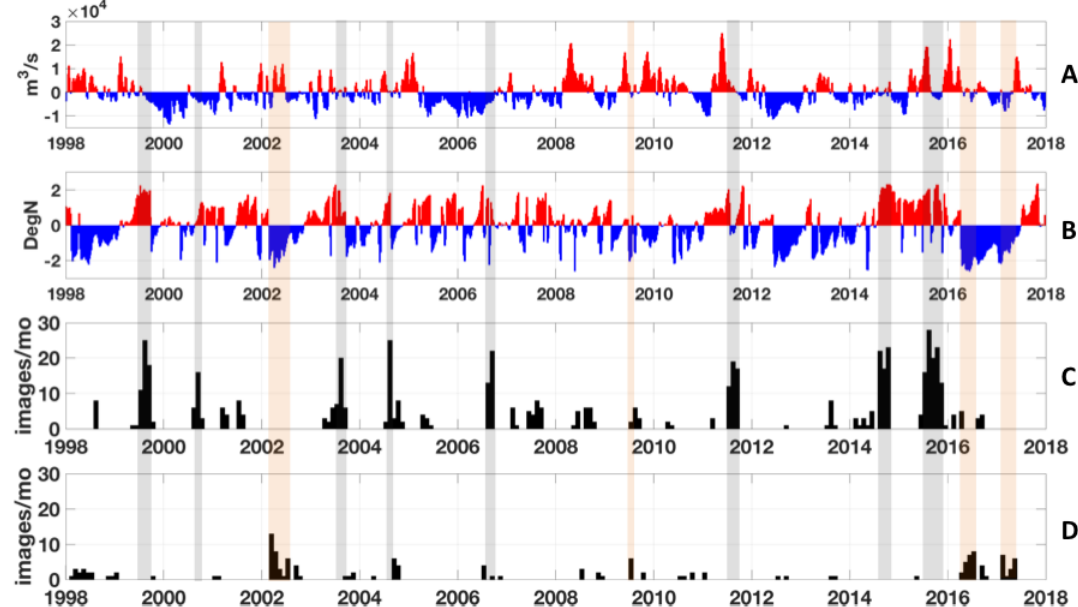
Figure 6. ( A ) Time series of anomalies of Mississippi River discharge. ( B ) Time series of anomalies of the northern extent of the Loop Current. ( C ) Time series of images per month showing evidence of the transport of water from the Mississippi Delta to the Florida Straits. ( D ) Time series of images per month showing evidence of transport from the Campeche Bank to the Florida Straits. In panels a–b, positive anomalies where time series values exceed climatological values are shown in red while negative anomalies are shown in blue. Gray shading indicates time periods when transport from the Mississippi Delta to the Florida Straits was prevalent. Orange shading indicates time periods when transport from the Campeche Bank to the Florida Straits was